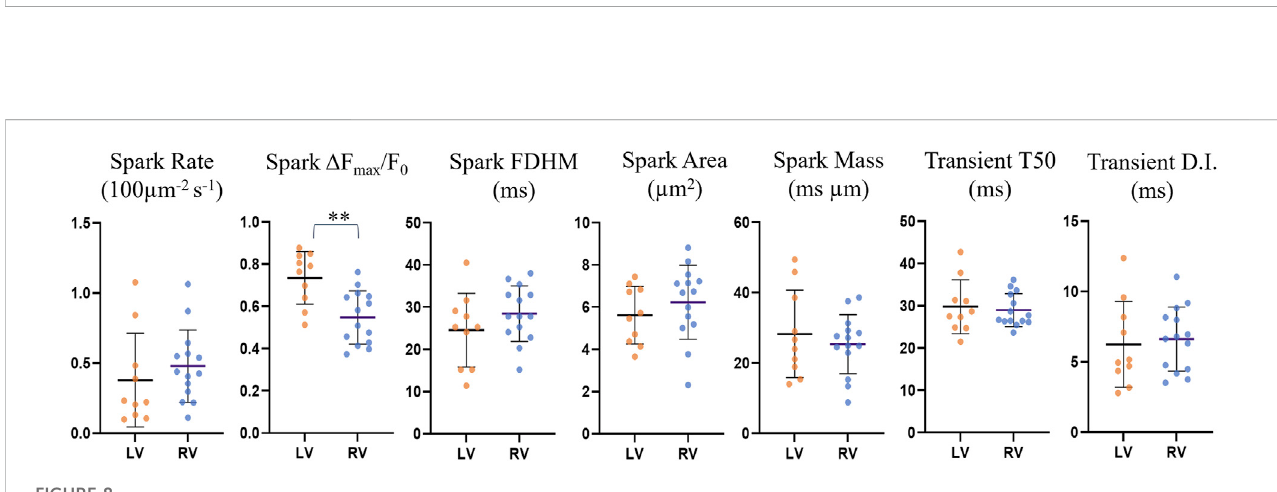
FIGURE 8 ComparisonofsparkandtransientparametersforLVandRVcardiomyocytesfortherestricted n =24dataset.Thehorizontallinesrepresenttheaverages across the medians for each cell within each ventricle population ( n LV = 10, n RV = 14). The error bars correspond to the standard deviation. The average spark amplitude in left ventricle cardiomyocytes was found to be 25% larger than those in right ventricle cardiomyocytes ( p = 0.0016,